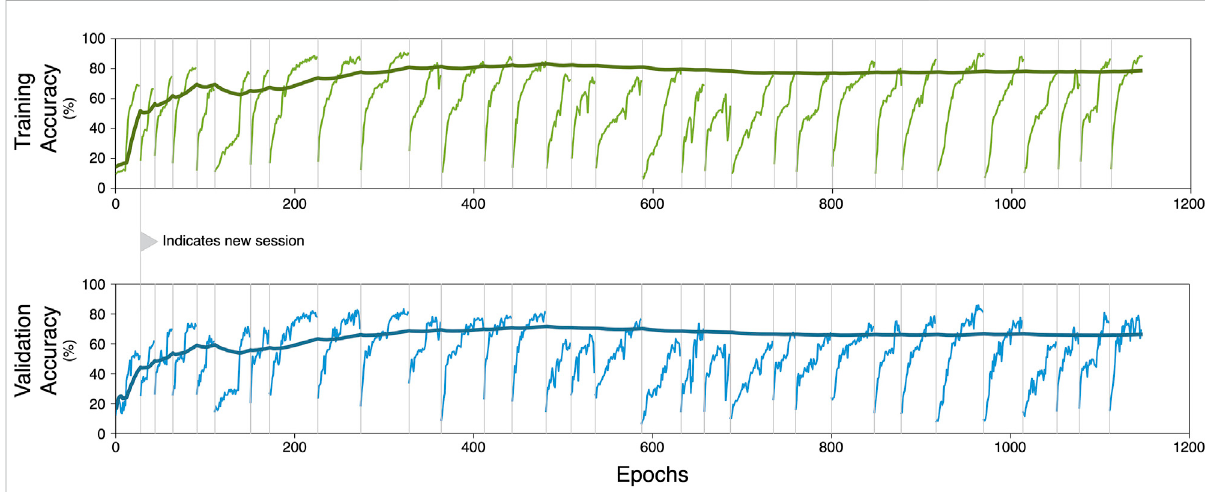
FIGURE 10 Accuracyduringtrainingandvalidationoftherecalibrationscheme.Startingwiththe fi rsttrainingsession,performanceincreasesasthenumber of training epochs increase. Eventually this performance reaches a plateau, at which we begin training on a new session to avoid over fi tting on speci fi c sessions. The switch of session data is marked by a vertical line and a subsequent initial drop in performance is observed. The performance accuracy on the overall set of used training data is shown as the bold